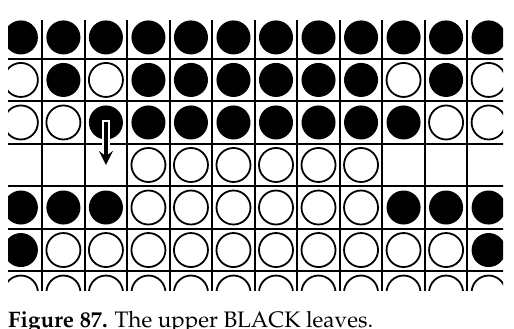
Figure 87. The upper BLACK leaves.